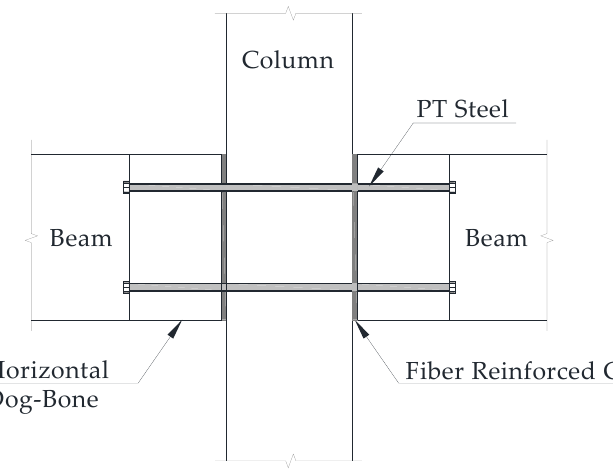
Figure 4. Horizontal dog bones with PT steel [26].